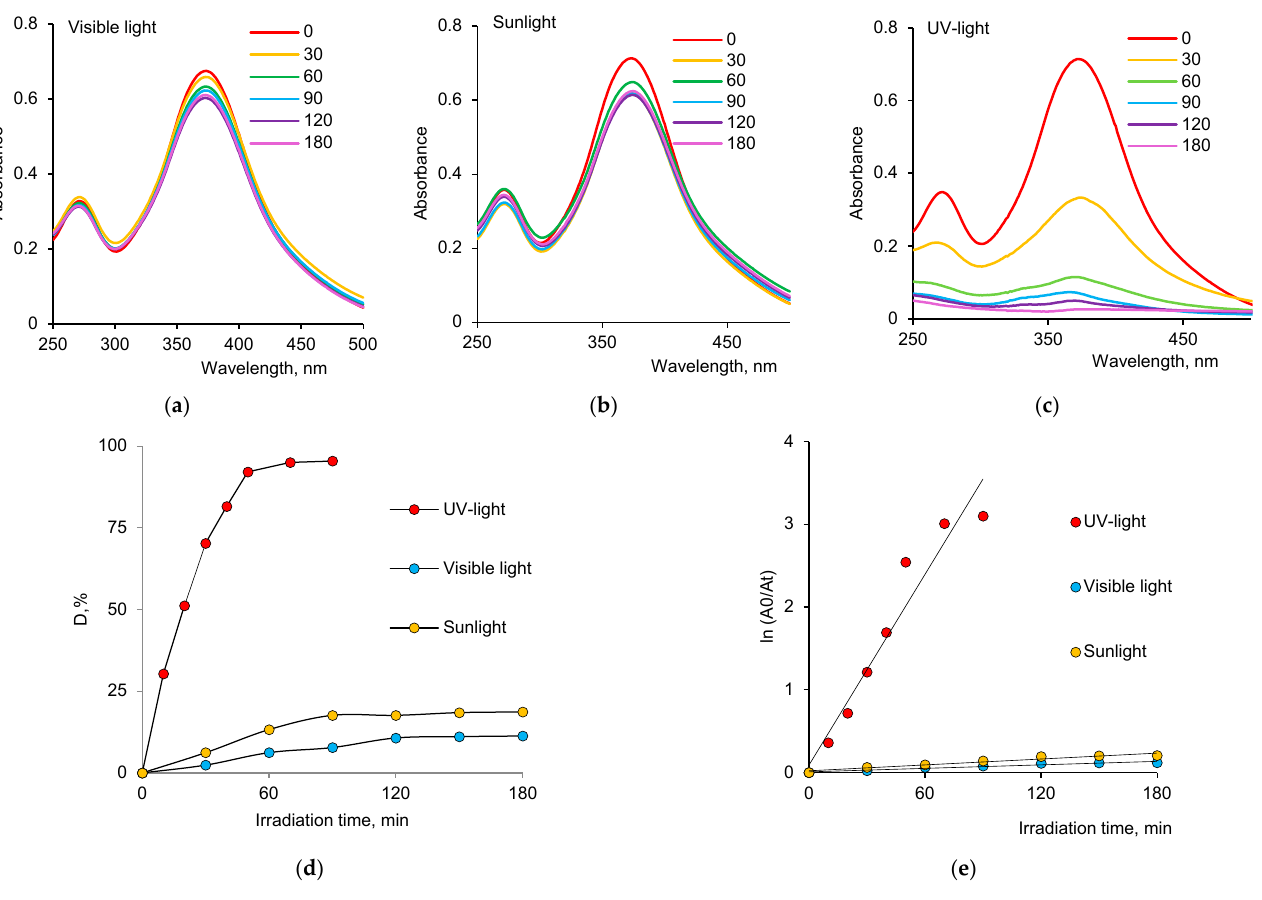
Figure 4. Absorption spectra of AY (1.0 mg/L) as a function of time in the presence of ZnO oxide nanoparticles (dye concentration—10.0 mg/L, loaded catalyst—50 mg) using visible light ( a ), sunlight ( b ) and UV-light ( c ), dye degradation efficiency (D, %) under different light sources ( d ) and Langmuir–Hinshelwood plot for the degradation of AY under different light sources ( e ).